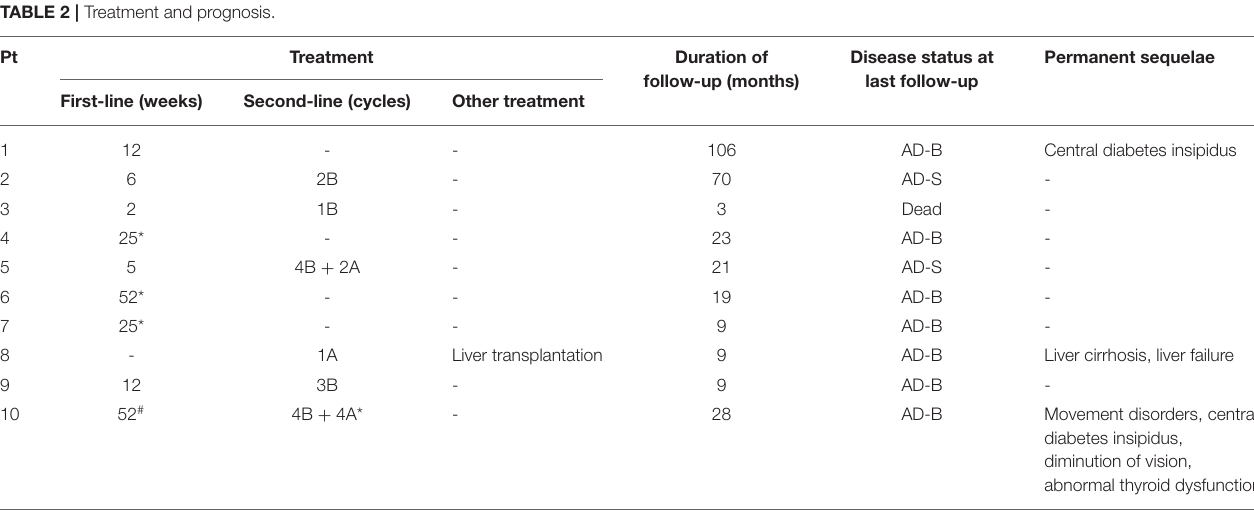
TABLE 2 | Treatment and